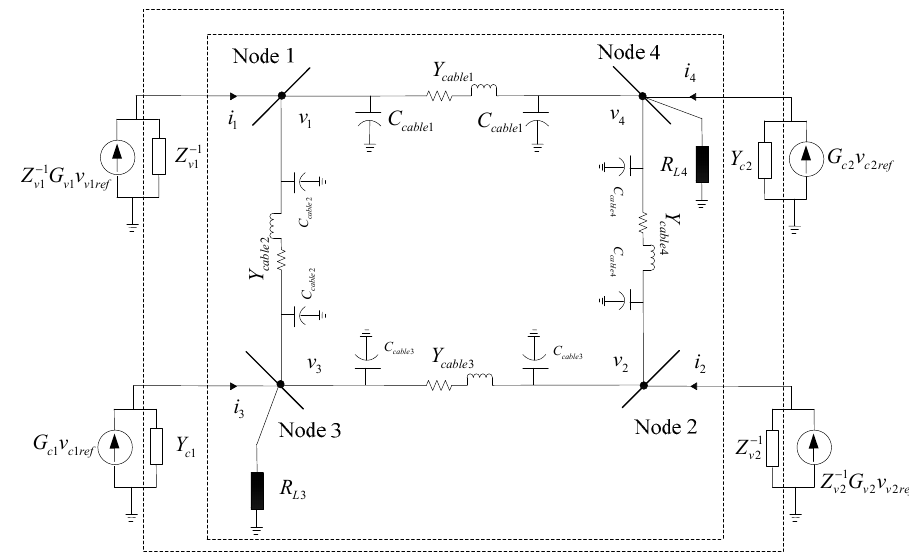
Figure 2. The equivalent Norton circuit of the studied meshed DC DPS.